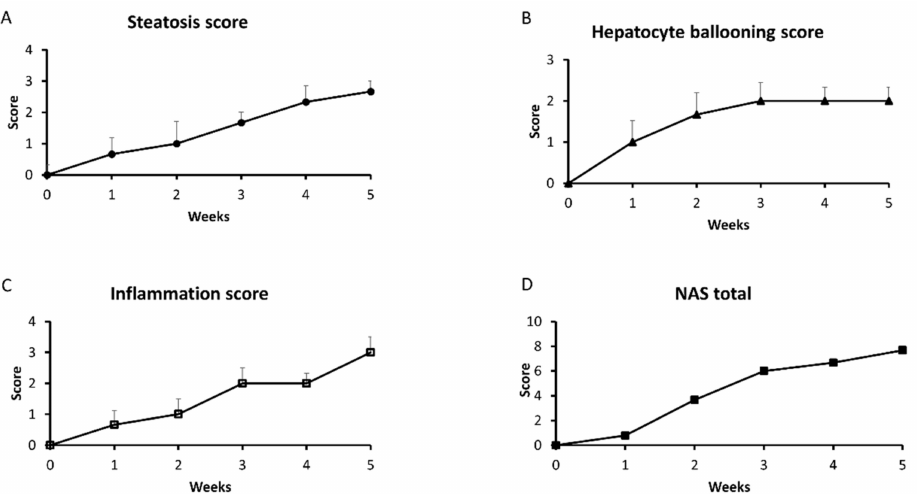
Figure 10. NAFLD activity score of the liver sections, i.e. liver steatosis score ( A ), hepatocyte ballooning score ( B ), inflammation score ( C ) and NAS total ( D ) from control group (0 week) and HFD group at the end of each experimental week (1, 2, 3, 4 and 5). Histological images were used for the scoring system as described in the ‘Materials and methods’